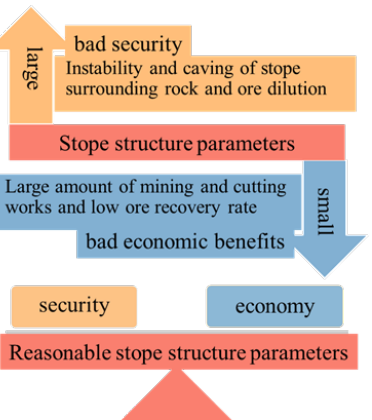
Figure 1. Influence of stope structural parameters on safety and the economy.